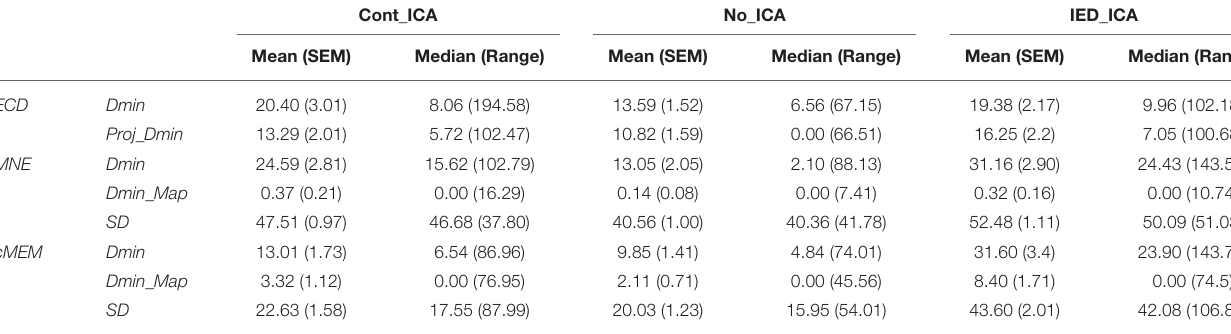
TABLE 2 | Descriptive